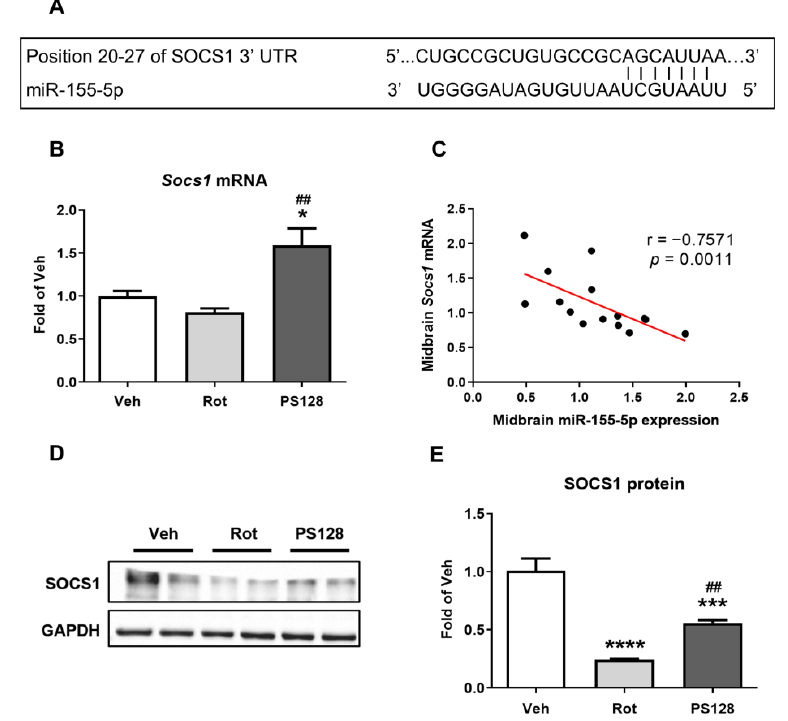
Figure 4. L. plantarum PS128 administration upregulated the expression of suppressor of cytokine signaling 1 (SOCS1) in rotenone-induced PD-like mice. ( A ) The conserved binding sites for miR-155-5p in the 3′ untranslated region (UTR) of SOCS1. ( B ) The gene expression level of Socs1 in the midbrain. ( C ) Correlation between the expression of miR-155-5p and Socs1 mRNA as determined by Spearman’s rank test. ( D ) Representative blots of SOCS1 in the midbrain. ( E ) Quantitative analysis of SOCS1 blots. N = 5 per group, * p < 0.05, *** p < 0.001, **** p < 0.0001 compared with the Veh group; ## p < 0.01 compared with the Rot group.